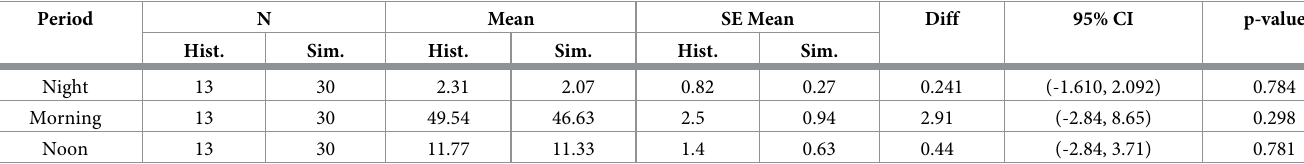
Table 5. Validation result. (Hist. = historical data, Sim. = simulation model).